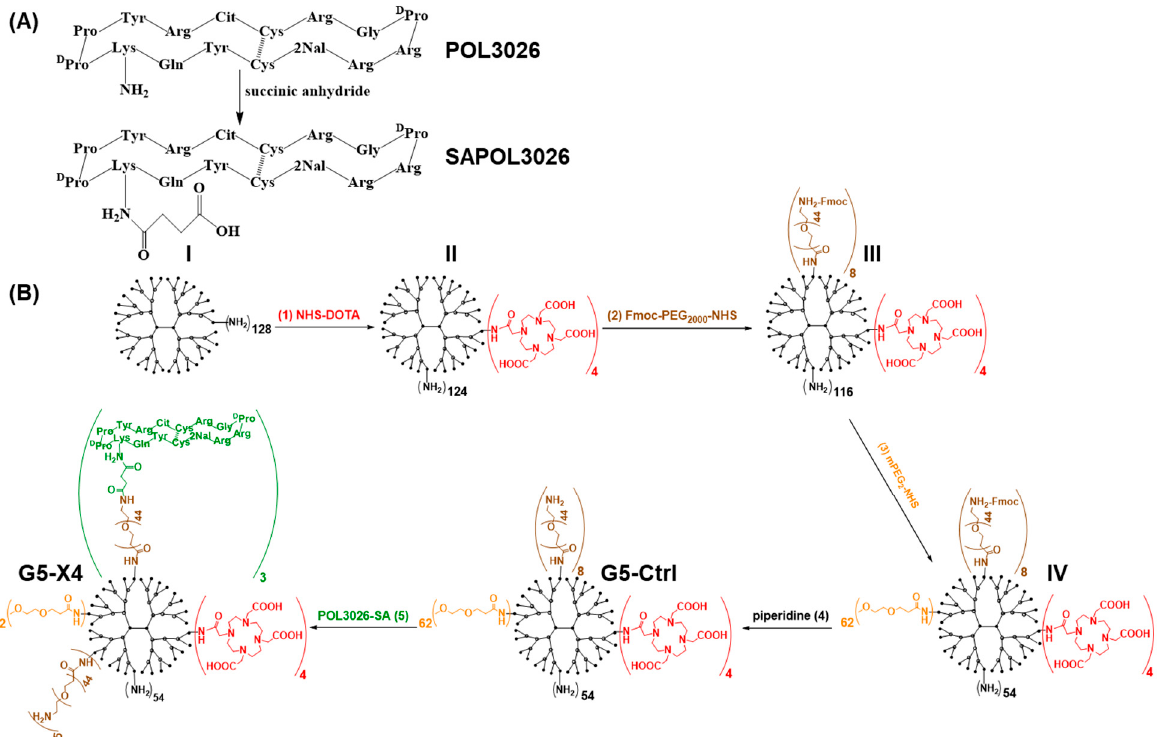
Figure 1. Synthesis of control G5-Ctrl and CXCR4-targeted G4-X4 dendrimers. ( A ) Selective modification of POL3026 with succinic anhydride. ( B ) Synthetic pathway leading to formation of control G5-Ctrl and CXCR4-targeted G5-X4 dendrimers. G5-Ctrl and CXCR4-targeted G5-X4